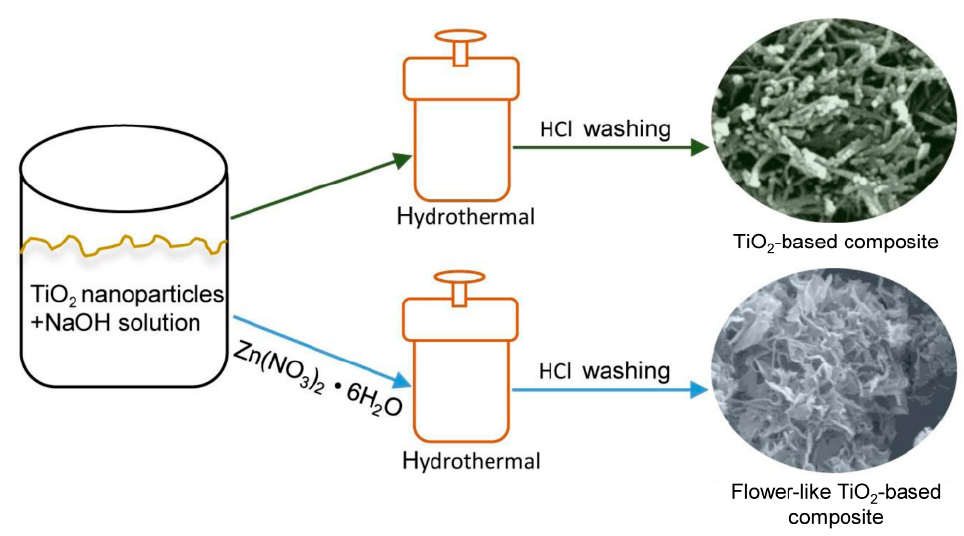
Figure 1. The proposed synthesis mechanism for flower-likeTiO 2 -based composite.